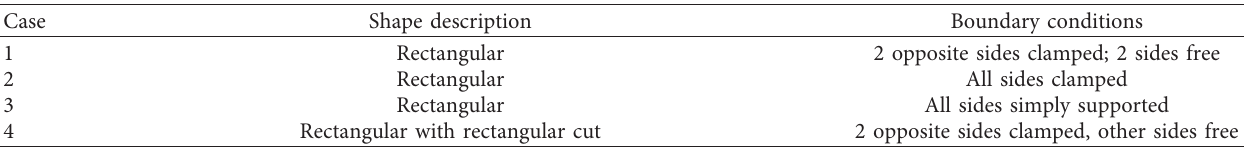
Table 1: Test cases.